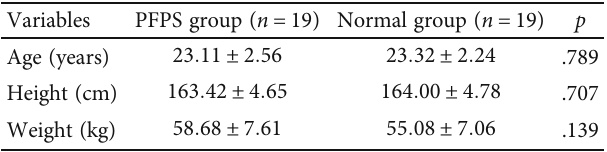
Table 1: Characteristic of participants.